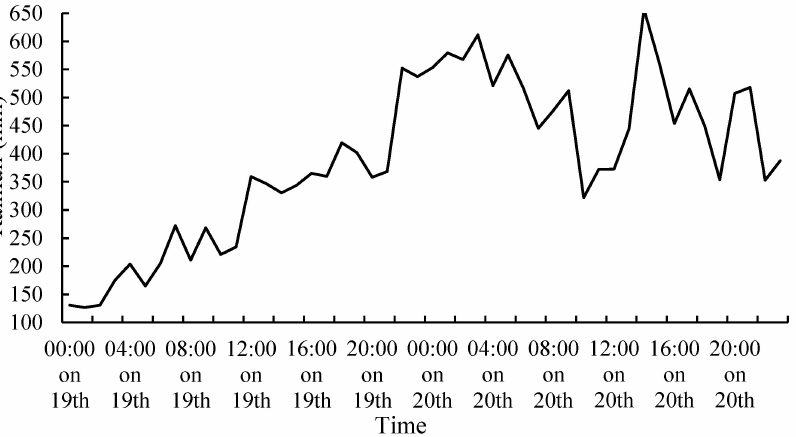
Figure 5. Hourly changes in total rainfall measured in the main precipitation area from 00:00